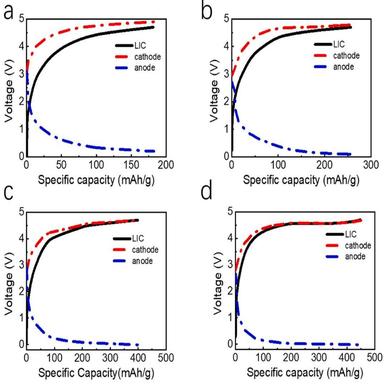
Potential curves of initial charging of (a) prAC-0.5//graphite, (b) prAC-1//graphite, (c) prAC-1.5//graphite and (d) prAC-2//graphite at a current density of 0.1 A/g.